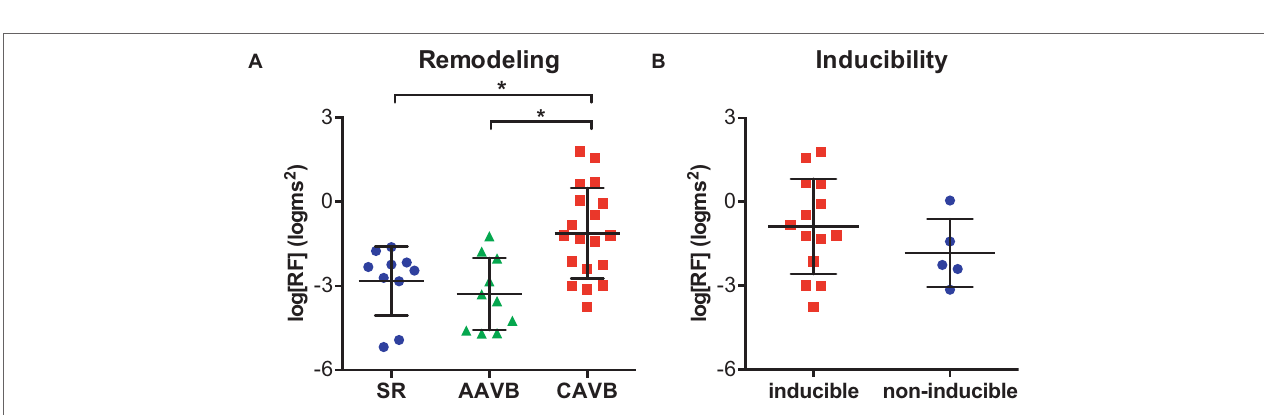
FIGURE 1 | Respiratory frequency oscillations in time and frequency domain. Representative examples of oscillations in monophasic action potential duration (MAPD) in the time domain (top) and frequency domain (bottom) during (A) sinus rhythm (SR), (B) acutely after creation of AV block (AAVB), and (C) after remodeling at chronic AV block (CAVB). A clear increase in a 0.2 Hz oscillation is seen at CAVB.